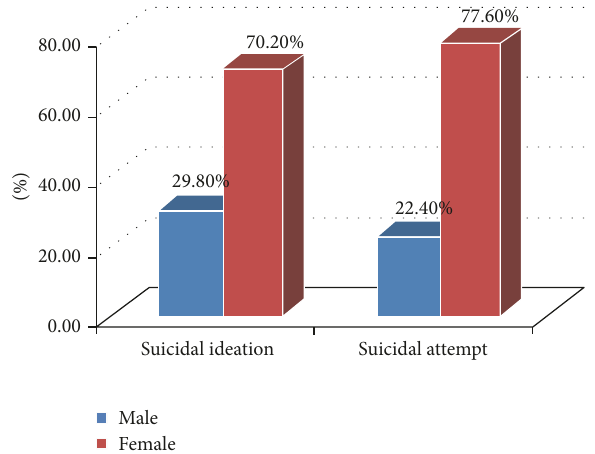
Figure1:Genderproportionofsuicidalideationandattemptamong HIV-positive patients at Zewditu Memorial Hospital, Addis Ababa, Ethiopia, June